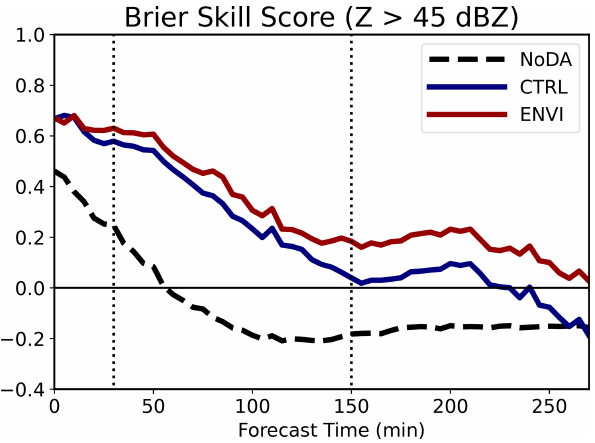
Figure 16. The BSS evaluating the P(Z > 45dBZ ) . Dashed black, solid blue, and solid red lines correspond with NoDA, CTRL, and ENVI, respectively. The horizontal black line marks no skill. Verti- cal dotted lines mark the times when forecast probabilities are eval- uated in Fig.